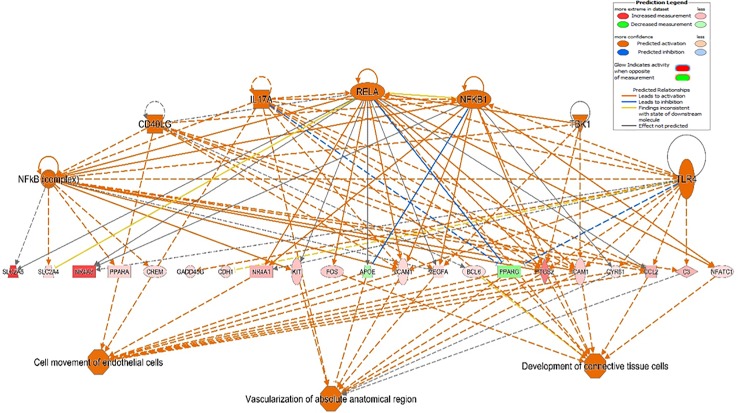
Top-scoring network of regulatory effects in crossbred fetuses.Upper tier: upstream regulators predicted to be activated (orange color). Middle tier: genes with altered expression in response to activation of upstream regulators (red = upregulation in crossbred; green = downregulation in crossbred). The shapes of the nodes reflect the functional class of each gene product: horizontal ellipse, transcriptional regulator; vertical ellipse, transmembrane receptor; vertical rhombus, enzyme; square, cytokine/growth factor; inverted triangle, kinase; and circle, complex/group/other. Direct interactions are represented by solid lines, while indirect interactions are represented by dashed lines. Orange lines lead to activation, while blue lines lead to inhibition. Lower tier: expected phenotypic consequences of gene expression changes based on data in the Ingenuity Knowledge Base (absolute z-score > 2 and p-value < 0.05). The octagonal symbol defines function.